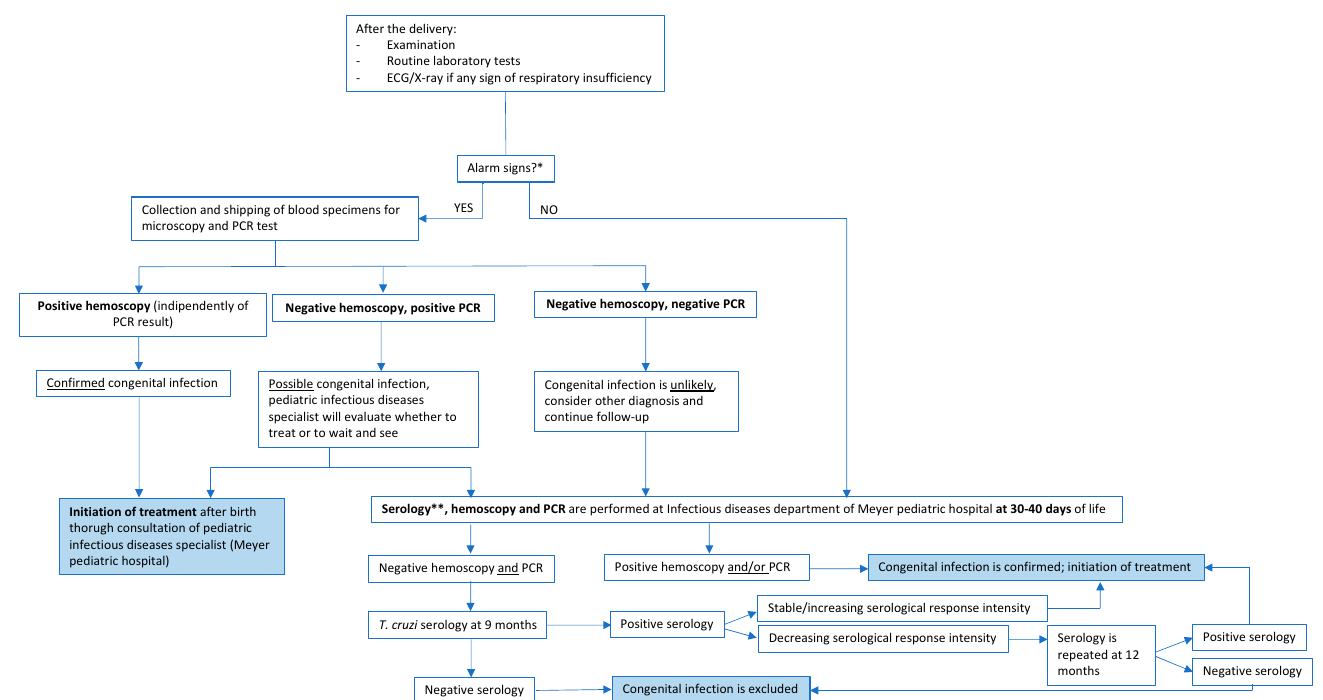
Figure 2. Scenarios and management of the infant born to a mother with Chagas disease. * Alarm signs include: overall impairment (Apgar score < 5 at 1 ′ , <7 at 5 ′ , weight < 2500 g, fever > 37.5 °C, hypothermia < 35 °C, lymphadenopathy, hepatosplenomegaly, jaundice, petechiae, edema or anasarca), signs of meningoencephalitis, myocarditis, respiratory distress, altered laboratory tests ** Serology performed at one month will be positive even in the absence of congenital infection, by passive transfer of maternal IgG antibodies. However, it is useful to make a comparison with the serology that will be performed at 9 months for a better interpretation of the result.